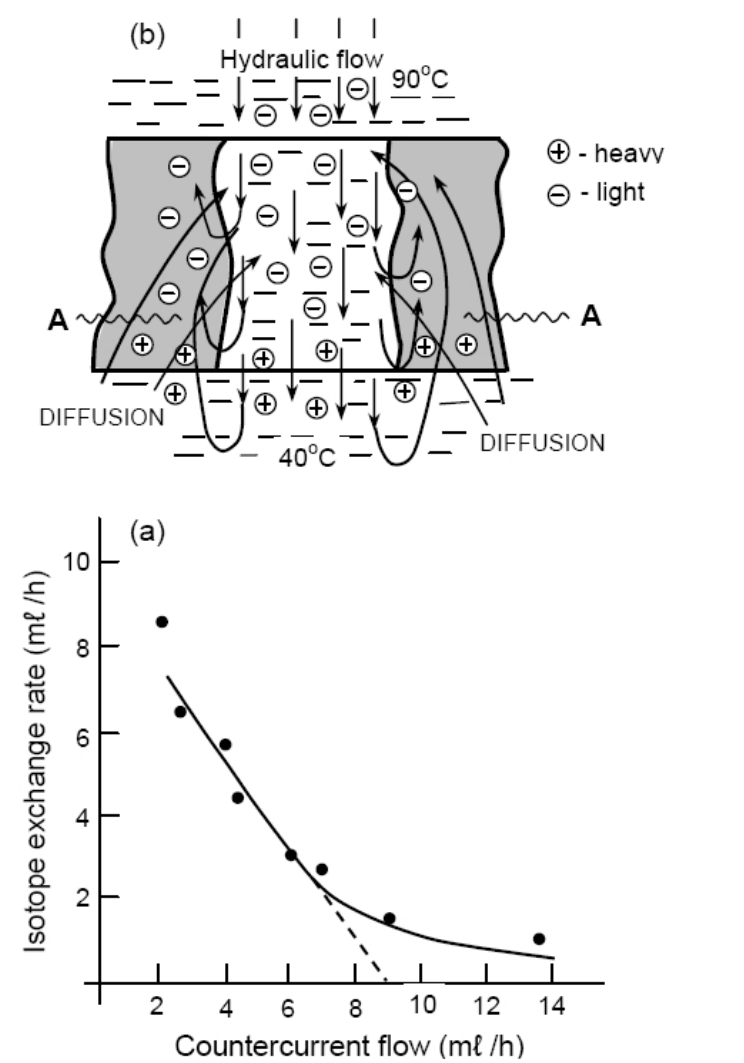
Fig. 6 Water exchange through the membrane against hydraulic flow: (a) the water exchange rate (ml h − 1 ) in the pressure vessel (4) is plotted as the function of counter hydraulic flow (ml h − 1 ) from this vessel through the membrane, and (b) a schematic rep- resenting the pore with hydraulic flow surrounded by the cellulose body of the